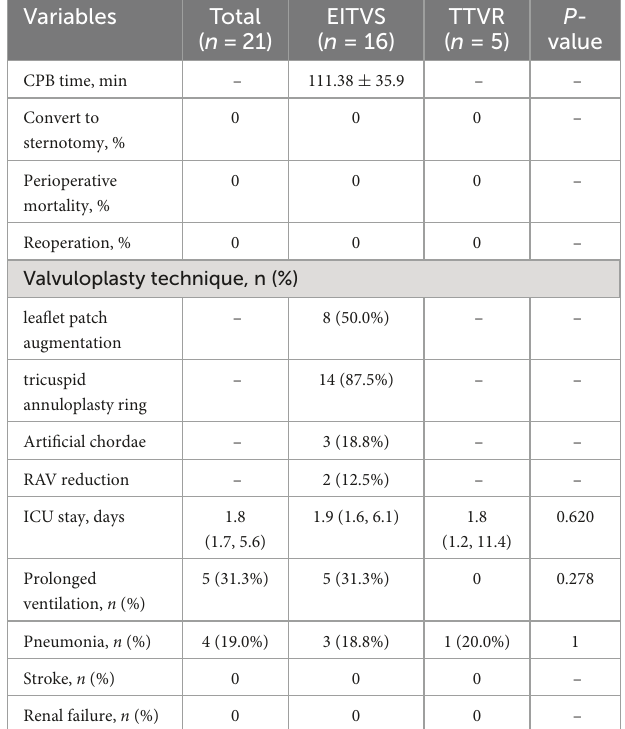
TABLE 2 Surgical outcomes.